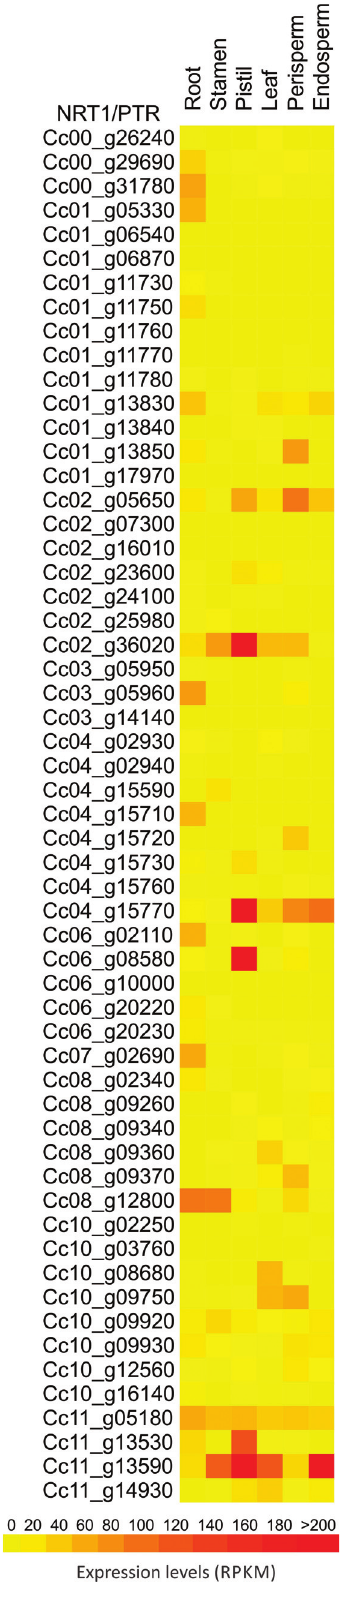
Figure 4 - In silico expression profile of C. canephora NRT1/PTR gene family. RNAseq data from roots, stamen, pistil, leaves, perisperm, and en- dosperm were obtained from Coffee Genome Hub